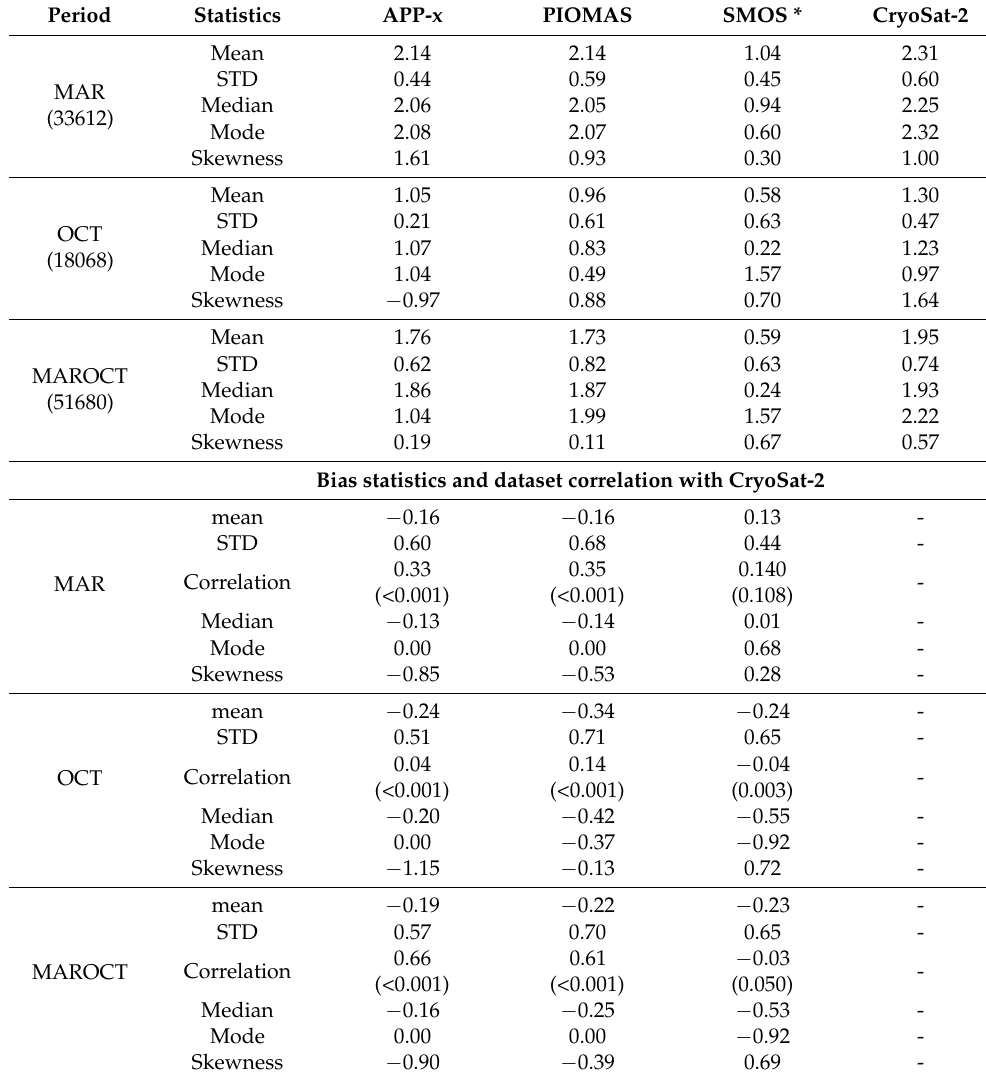
Table 3. Descriptive statistics of ice thickness in the four datasets (top half) and their differences and correlation with CryoSat-2 thickness (bottom half) in the two CryoSat-2 periods (meters). MAR is March; OCT is October; MAROCT is March and October. The number in parentheses beneath the period name is the total number of pixels used for the comparison in that period. P-values are given in parentheses beneath the correlation coefficients.